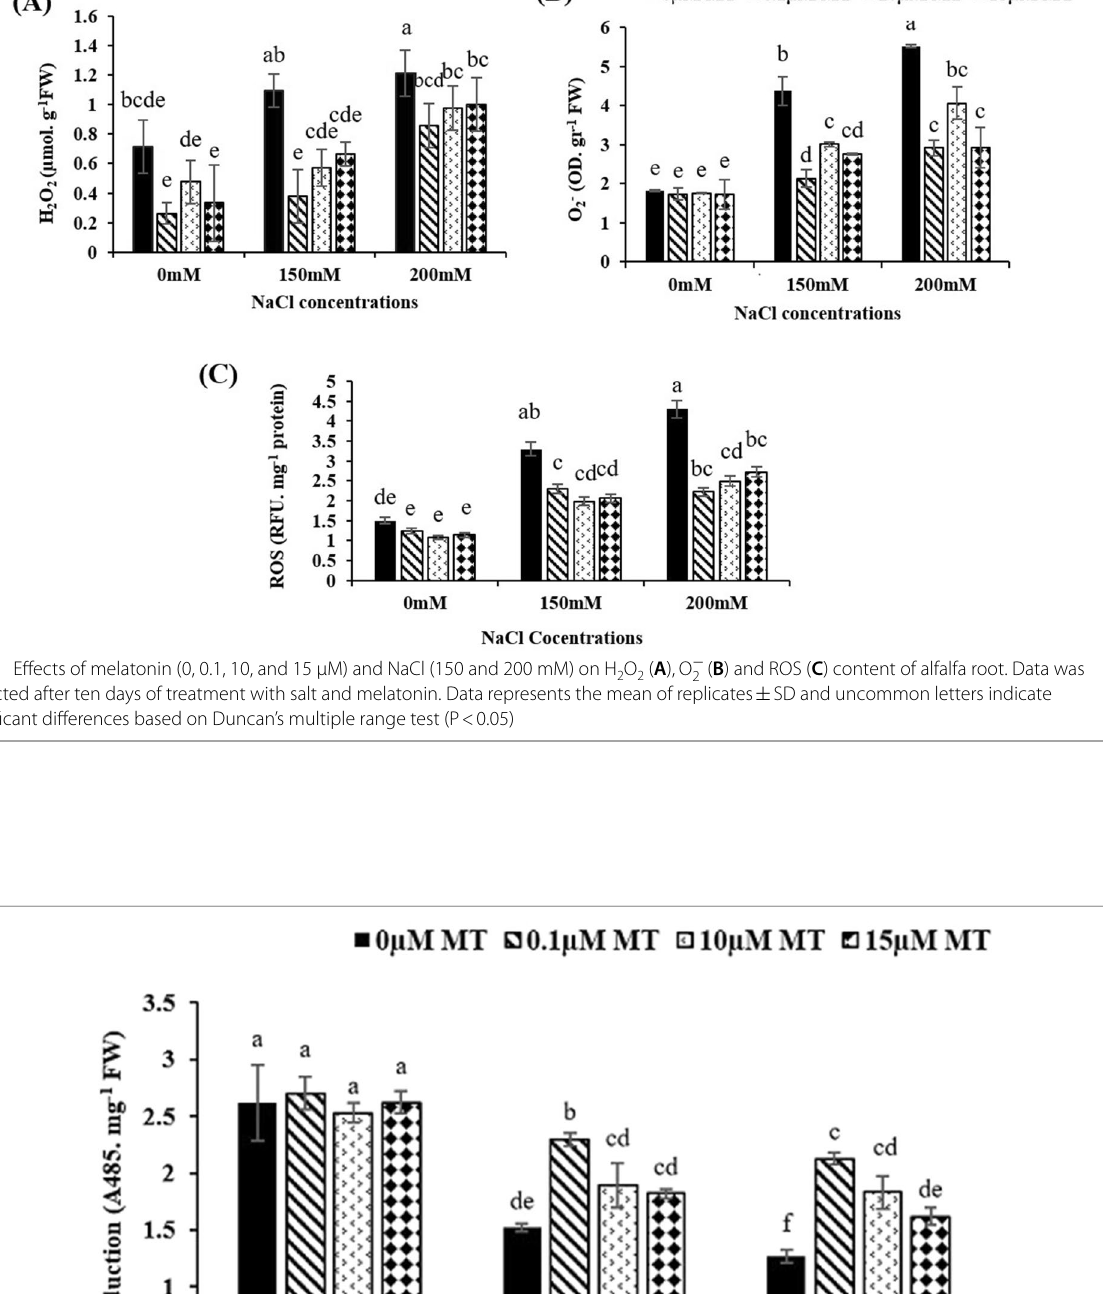
SD and uncommon ±